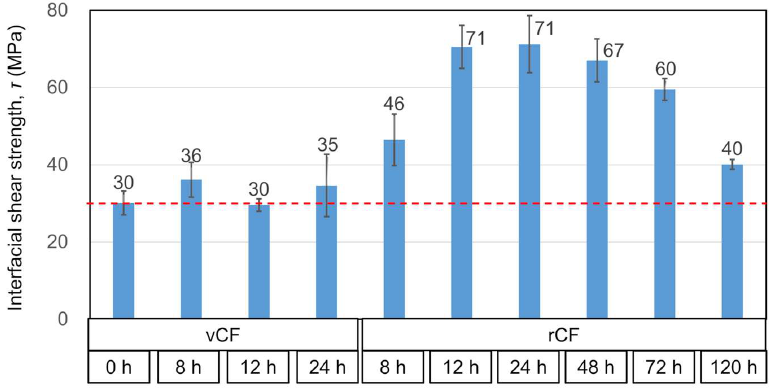
Figure 4. Interfacial shear strength between carbon fiber and resin at resin droplet size L = 70 μm for vCF, vCF 8 h–24 h, and rCF 8 h–120 h.